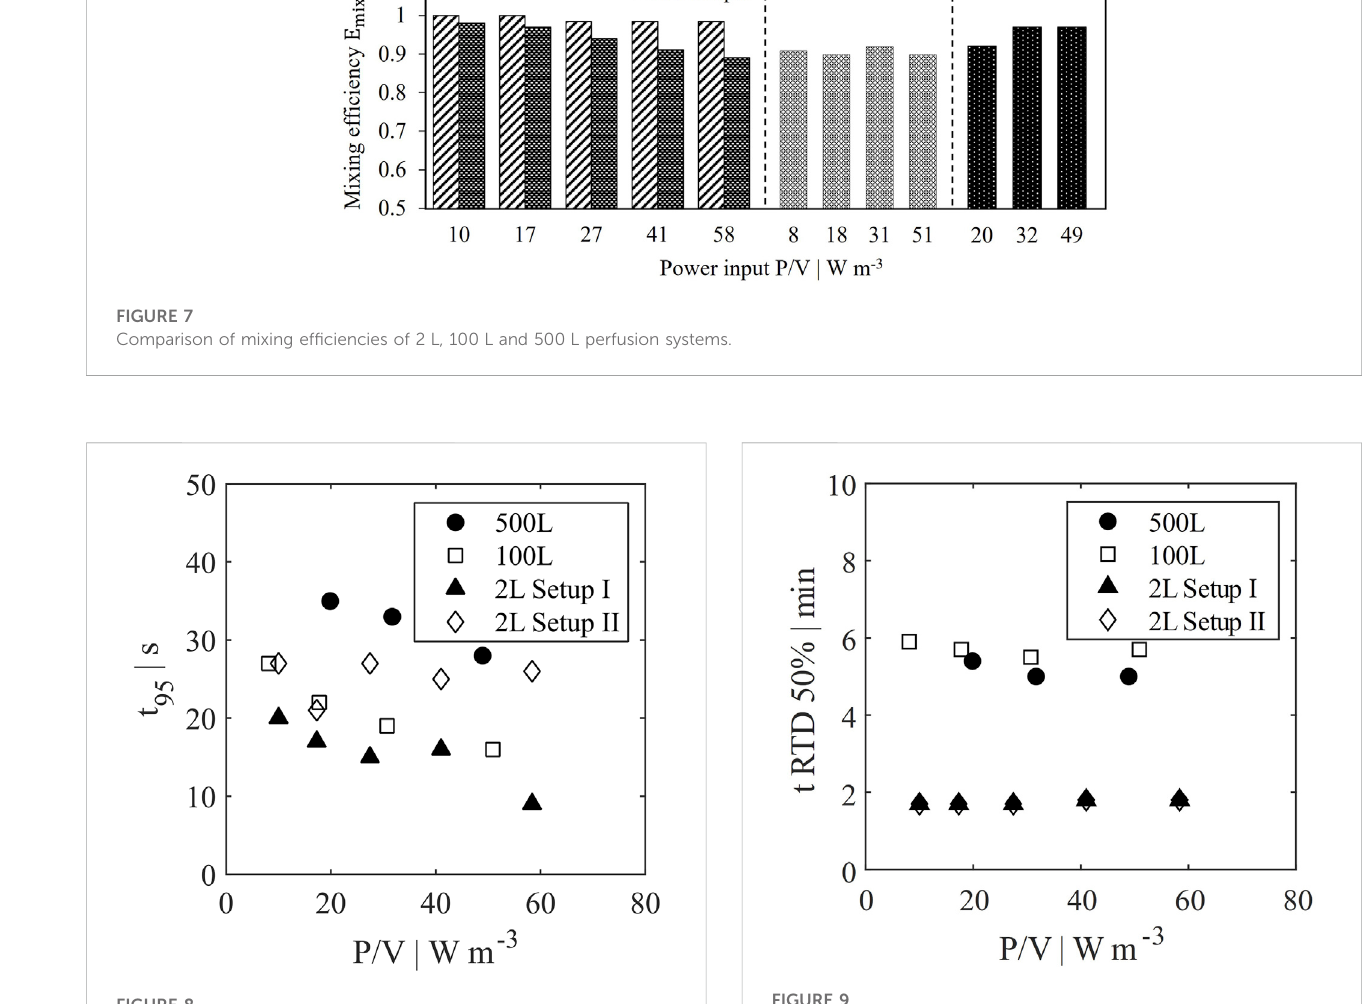
FIGURE 8 Comparison of mixing times t95 of 2 L, 100 L and 500 L perfusion systems.